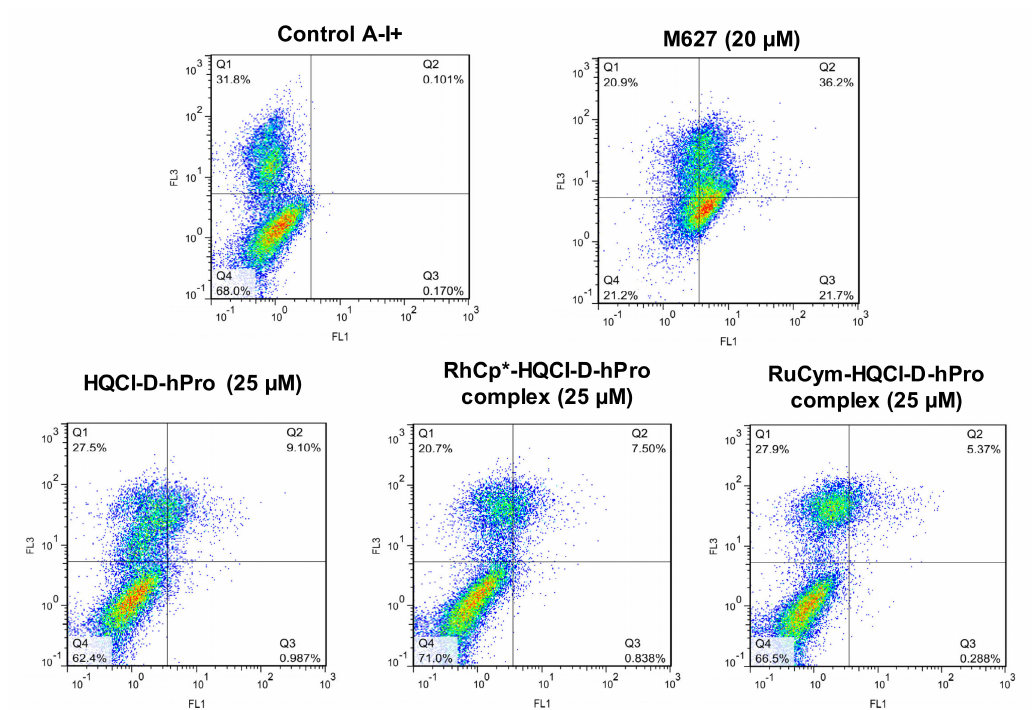
Figure 3. Apoptosis induction by metal complexes on MDR Colo-205 adenocarcinoma cells at 25 µ M. M627 at 20 µ M was applied as a positive control. Cell populations based on the flow cytometric analysis: Q1 : dead cells (annexin negative, propidium iodide positive) (A − , PI+); Q2 : late apoptotic cells (annexin positive, propidium iodide positive) (A+, PI+); Q3 : early apoptotic cells (annexin positive, propidium iodide negative) (A+, PI − ); Q4 : living cells (annexin negative, propidium iodide negative) (A − , PI − ); FL1: fluorescence of annexin V-FITC; FL3: fluorescence of propidium iodide.